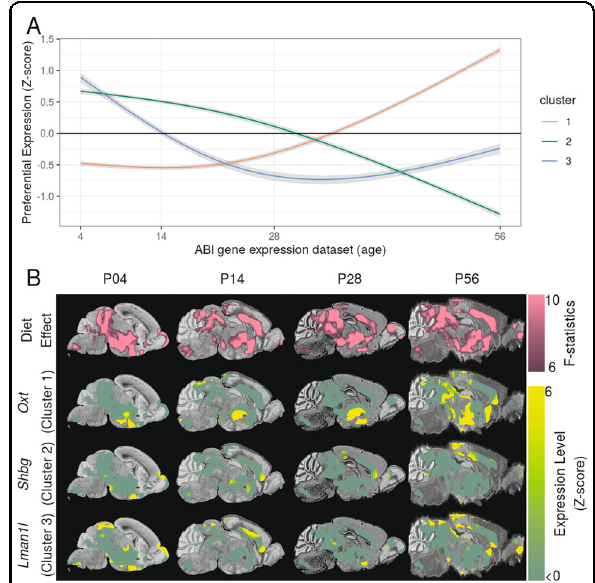
Fig. 5 Genes expressed in brain regions sensitive to early-life diet over the course of mouse development. Brain regions where early- life diet had a highly signi fi cant effect (FDR < 0.01) on adult neuroanatomy de fi ne the ROI ( B fi rst row). The ROI was transformed to the nissl atlases de fi ning the ABI gene expression dataset (background images in B ) and the spatial expression of genes were quanti fi ed throughout the course of postnatal development. A Three clusters of spatio-temporal gene expression were found: genes with low expression in ROI during neonatal life and increased ~P28 (Cluster 1), and genes with high expression during neonatal life and decreased during ~P28 and ~P14 (Cluster 2 and 3, respectively). Oxt (Cluster 1) was chosen as a representative example of an ASD-associated gene (image row 2 in B ). Shbg and Lman1l had the highest expression in Cluster 2 and 3 respectively and shown as representative examples (image row 3 and 4 in B ). Shaded regions represent 95% con fi dence intervals. Gene expression fold-change maps were expressed as a Z - score and masked by the ROI for